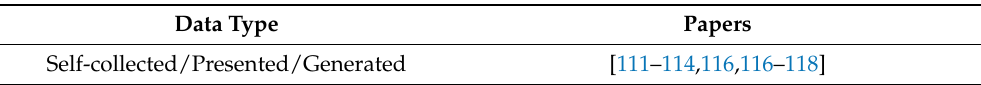
Table 14. Data types for Smart Infrastructure.